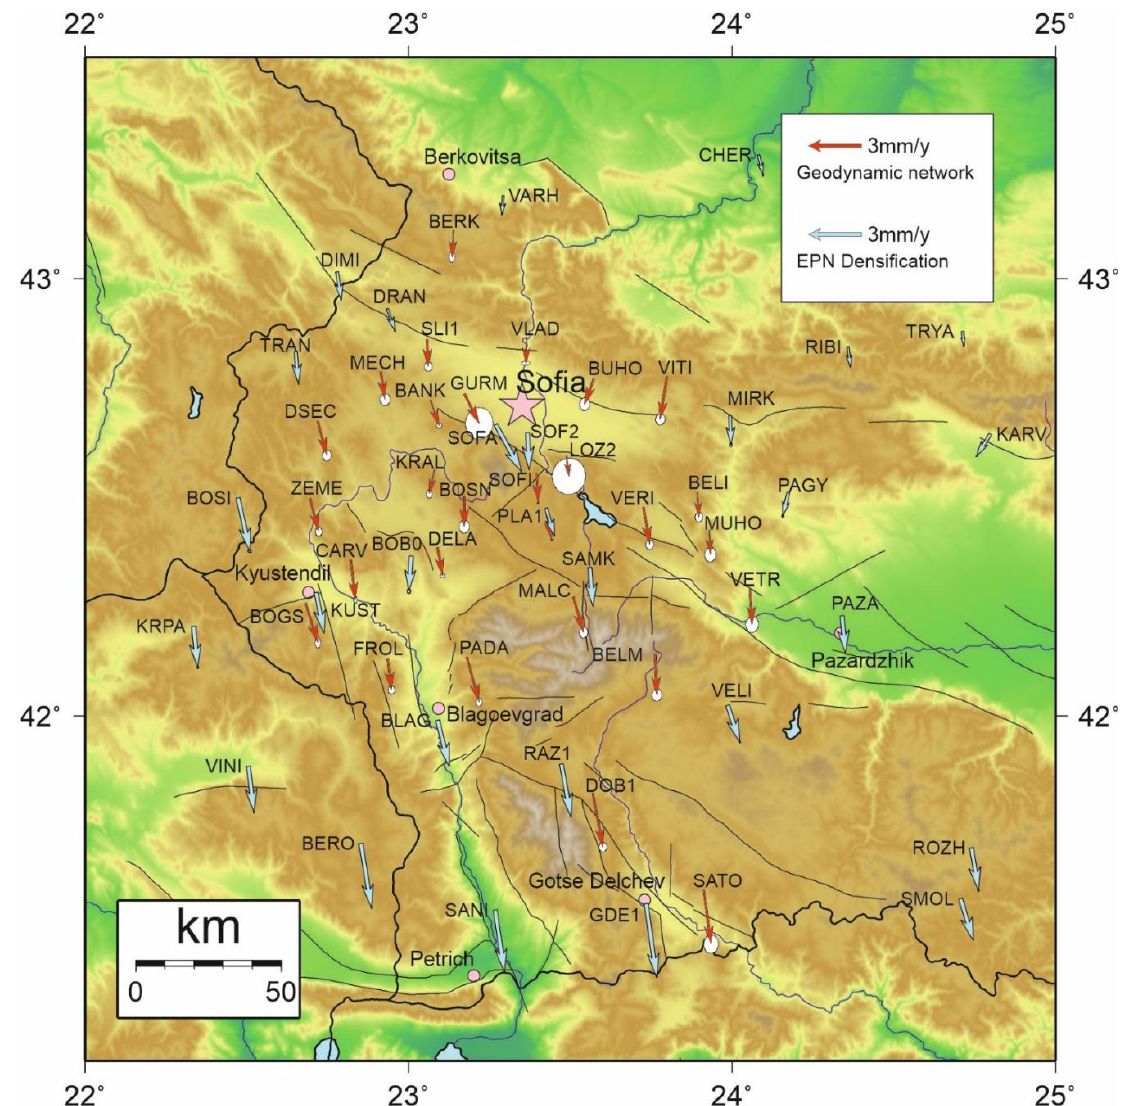
Figure 3. Horizontal velocities of the point from Sofia geodynamic network ( red arrow ) and from the EPN densification ( light blue arrow ).